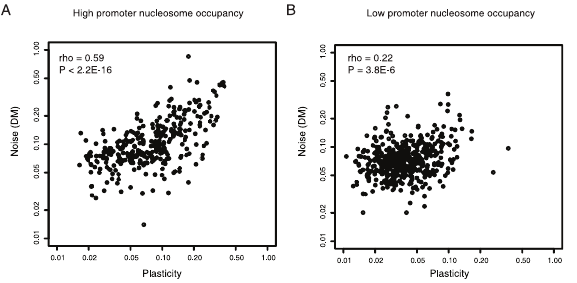
Figure 2. Noise–plasticity coupling is associated with promoter chromatin structure. Noise–plasticity coupling for genes with high proximal promoter nucleosome occupancy [15] (A) and low proximal promoter nucleosome occupancy (B). Here only genes not required for growth or viability are considered. The comparison for all genes and for genes transcribed from non-TATA promoters is shown in Figure S1. Spearman correlation coefficients and P-values are shown inset.